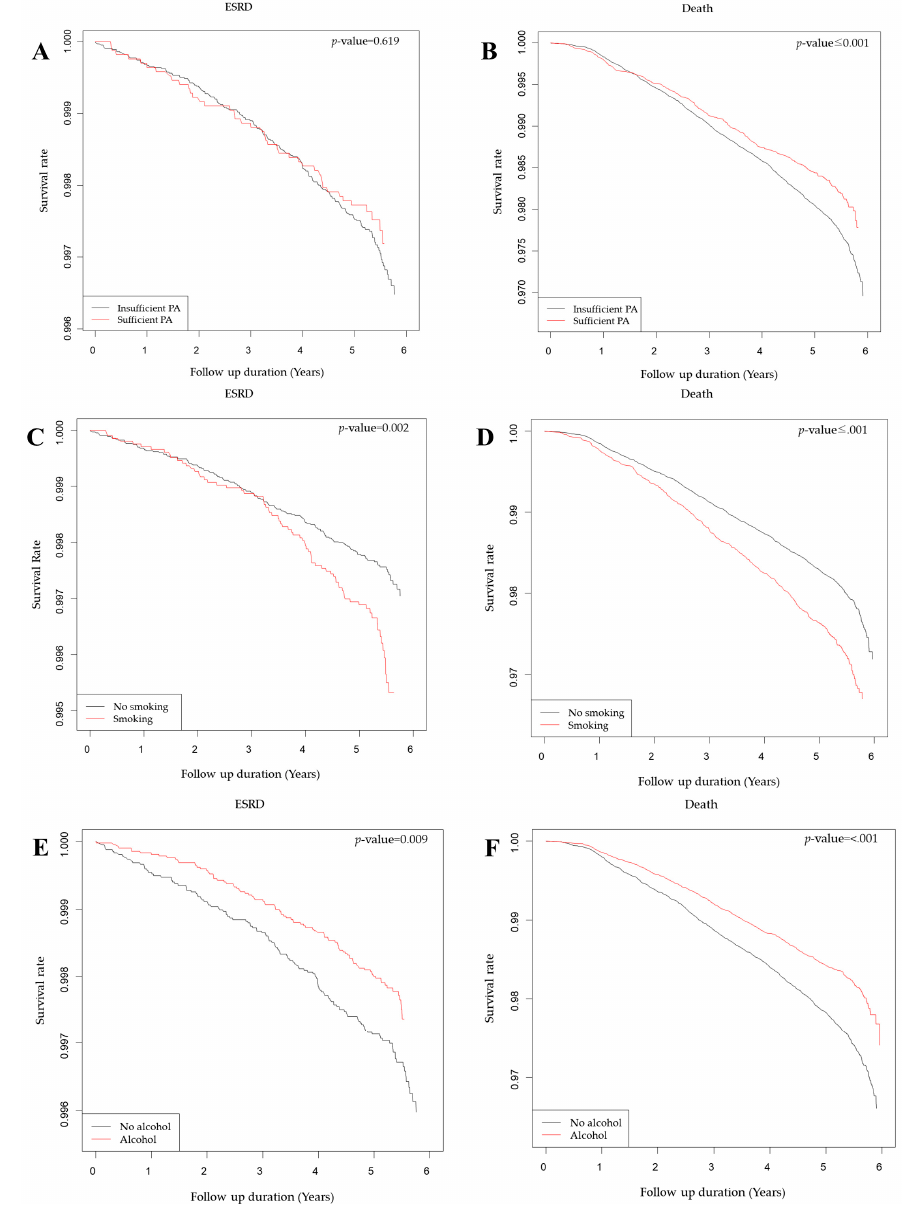
Figure 3. Kaplan–Meier curves for end-stage renal disease (ESRD) and mortality according to sufficient physical activity (PA) ( A , B ), smoking ( C , D ), and alcohol consumption ( E , F ).